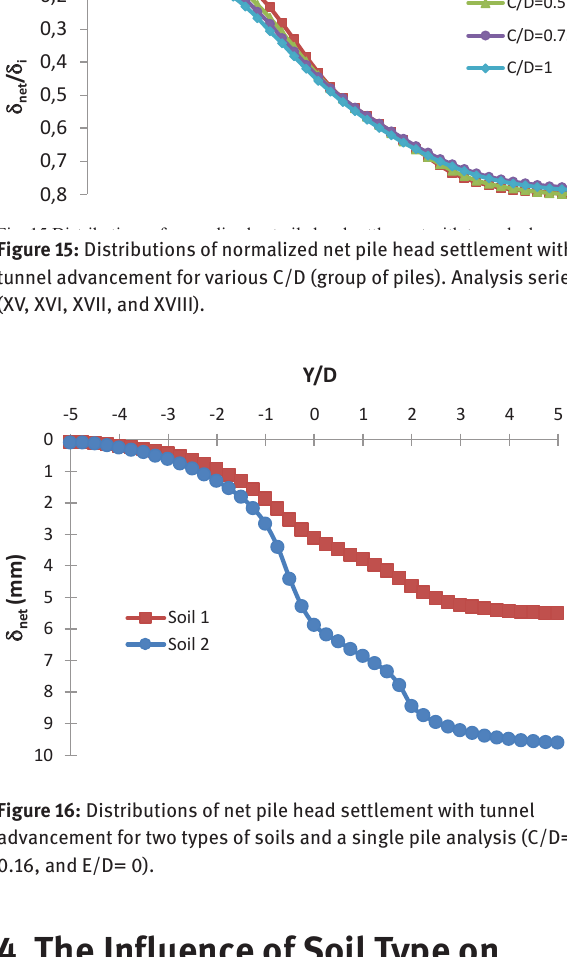
Figure 16: Distributions of net pile head settlement with tunnel Fig. 16 Distributions of net pile head settlement with tunnel advancement for two types of soils and a advancement for two types of soils and a single pile analysis (C/D= single pile analysis (C/D= 0.16, and E/D= 0) 0.16, and E/D= 0). .